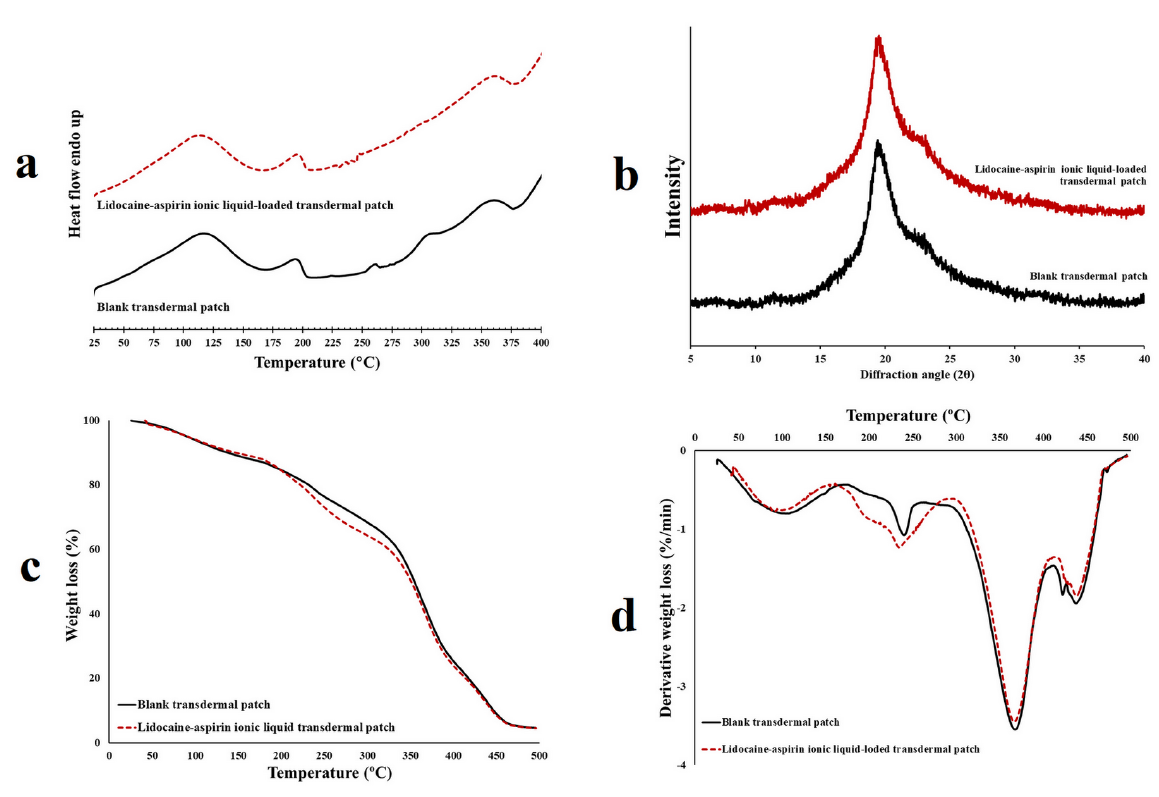
Figure 3. Characterization of the lidocaine/aspirin ionic liquid-loaded transdermal patch: (a) DSC thermogram, (b) XRD patterns, (c) TGA thermogram, and (d) DTG